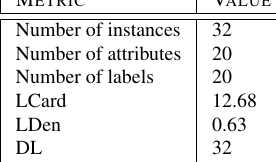
Table 5: Features of the EDM multi-label data set M ETRIC V ALUE Number of instances 32 Number of attributes 20 Number of